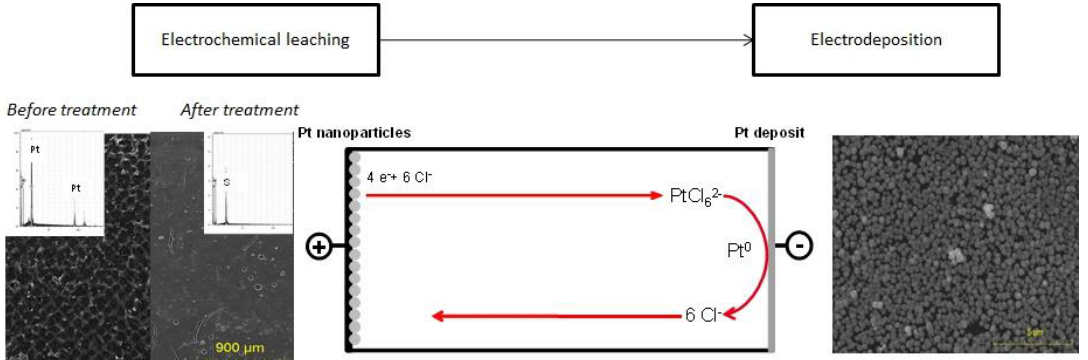
Figure 8. Electrochemical recovery of platinum used in PEMFC electrodes in a 1-butyl-3-methyl imidazolium bis (trifluoromethyl) sulfonyl imide (BMIM TFSI) + BMIM Cl melt containing 7.5 mM of leached Pt under inert and ambient atmosphere.